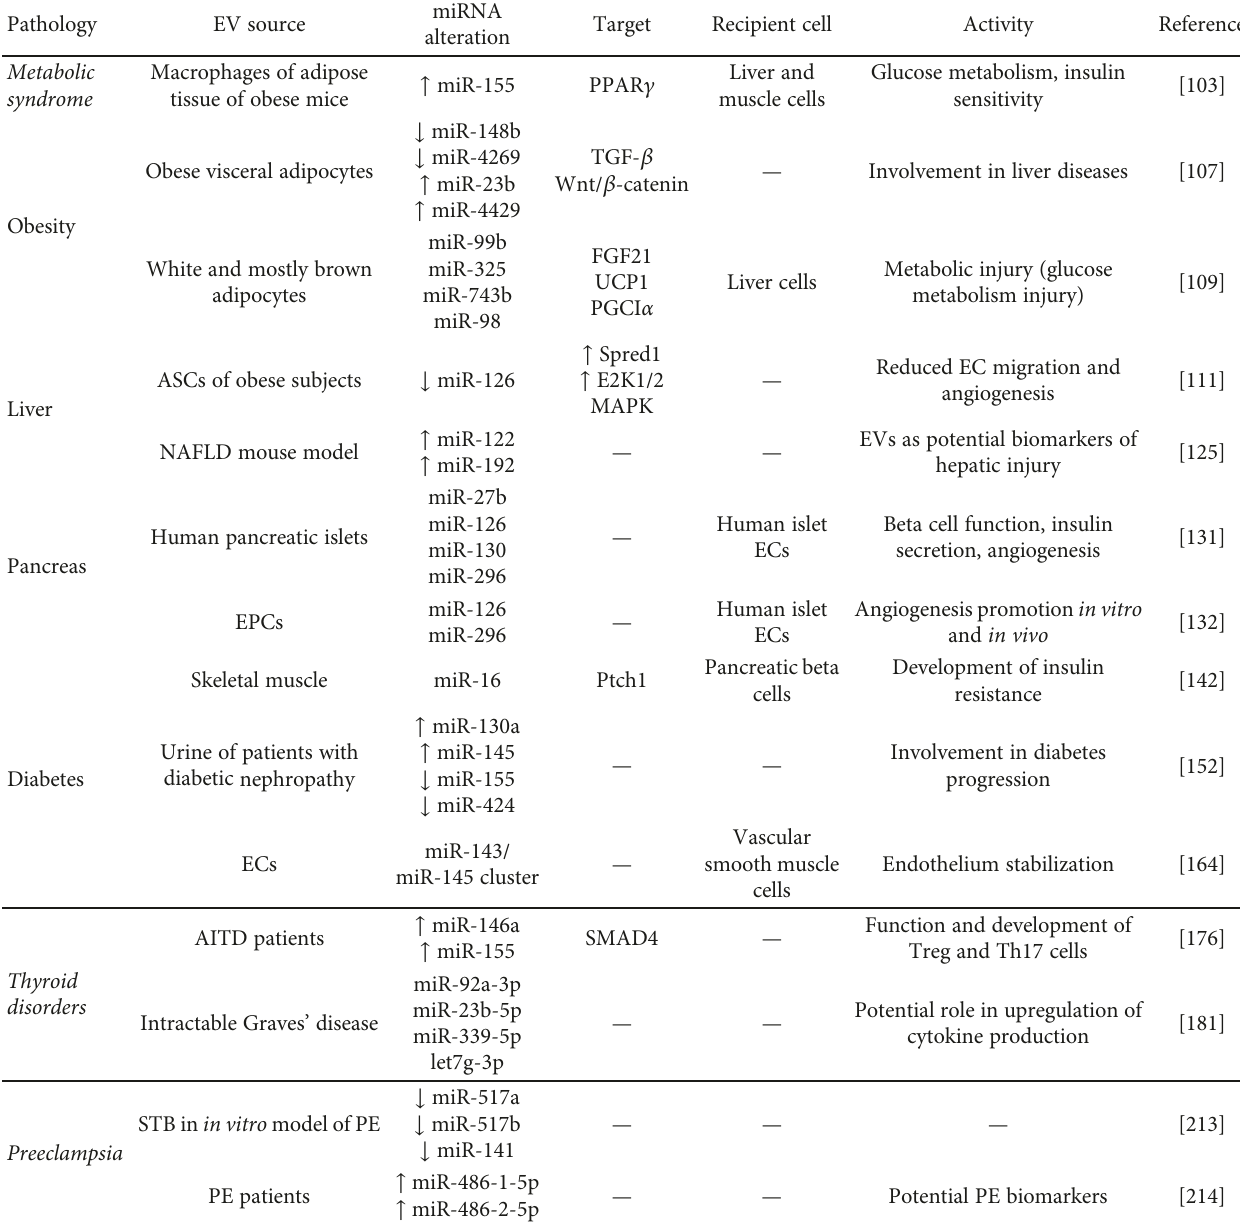
Table 1: EV-miRNA molecules in endocrine